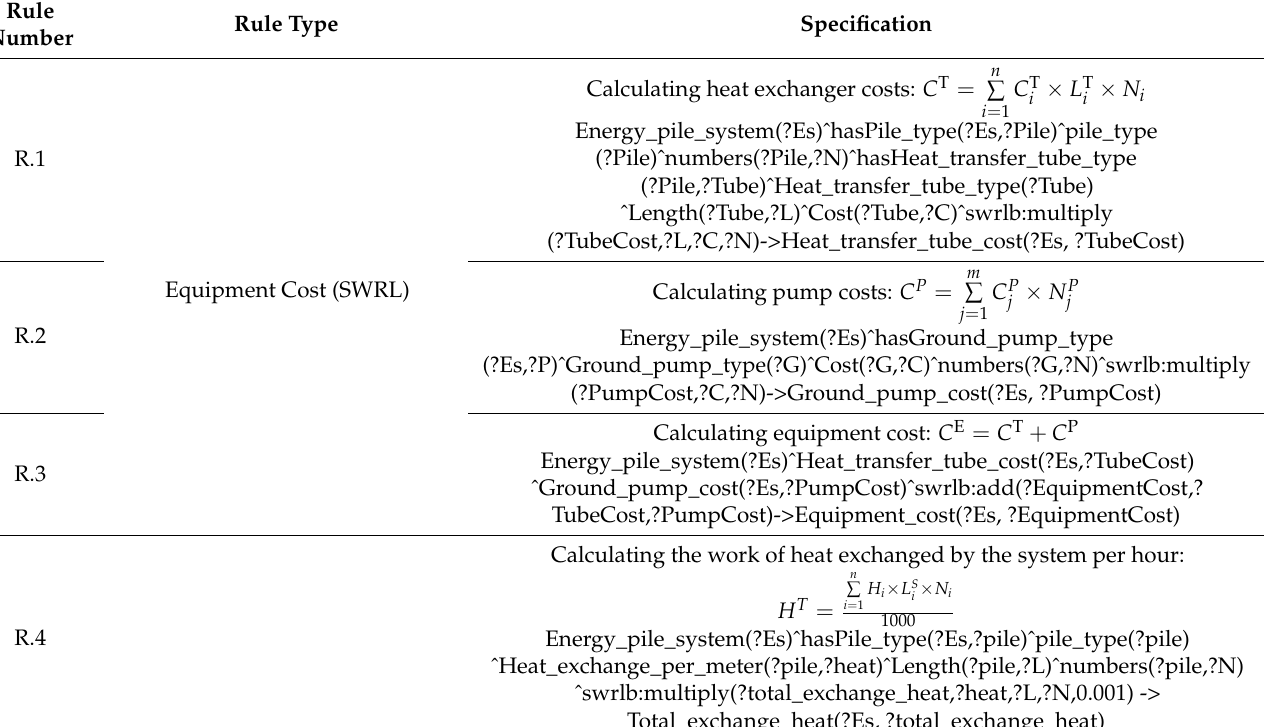
Table 3. Preset SWRL and SQWRL